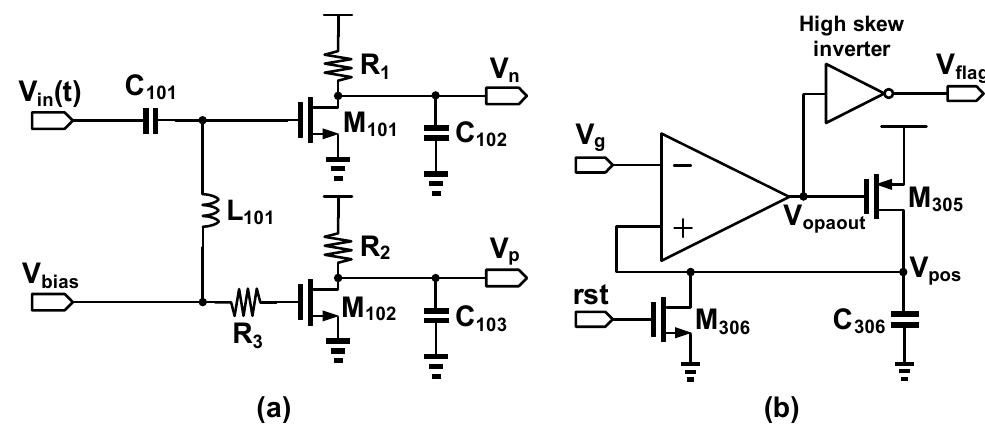
Figure 4. Schematic of ( a ) amplitude-to-voltage converter (AVC) and ( b ) peak detector.